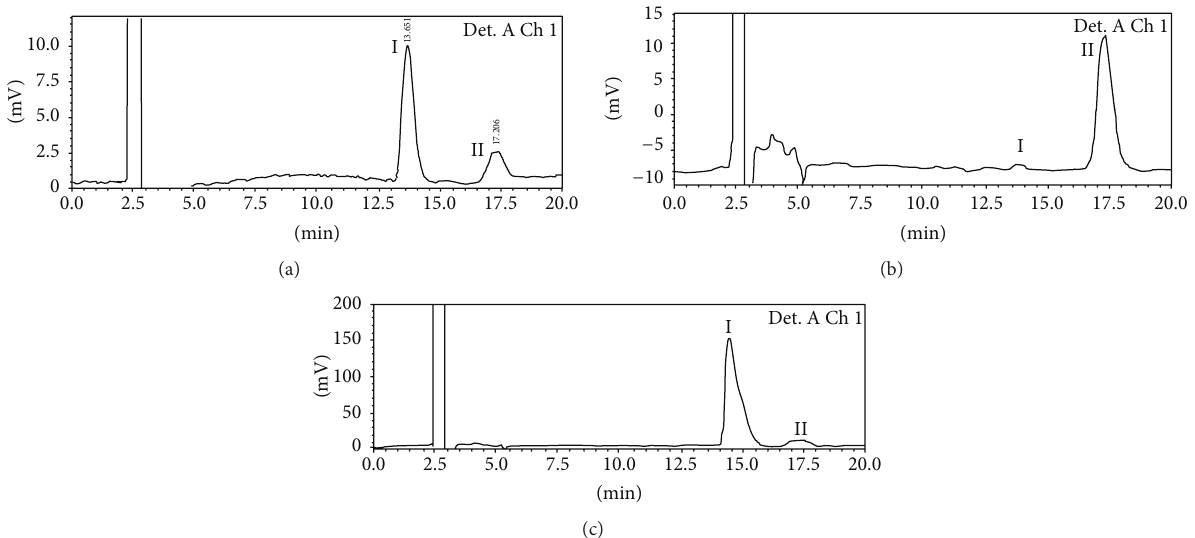
Figure 3: Chromatogram by HPLC-RID: (a) standard lactose-lactulose; (b) UHT milk sample; (c) condensed milk sample. I: lactulose (13.6min); II: lactose